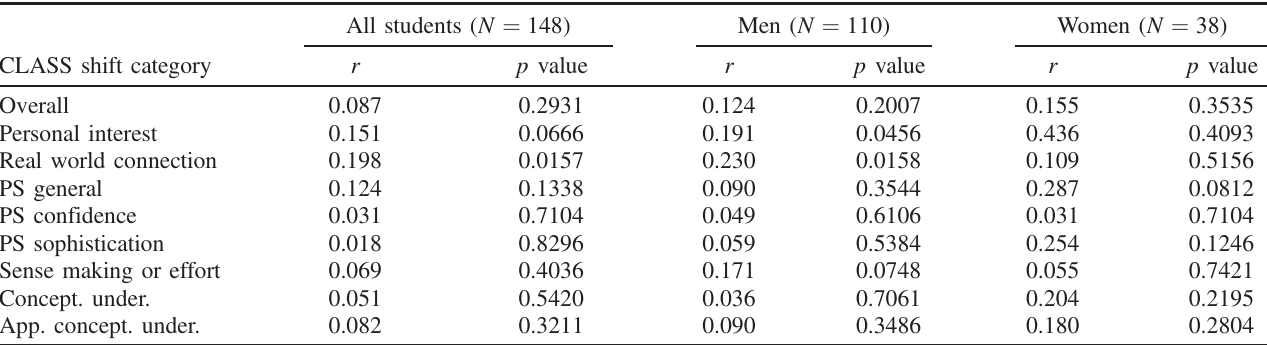
TABLE IX. Correlation of the FCI prescore and CLASS shifts, separated by category, for all students, men, and women. The regression coefficient r and the p value are